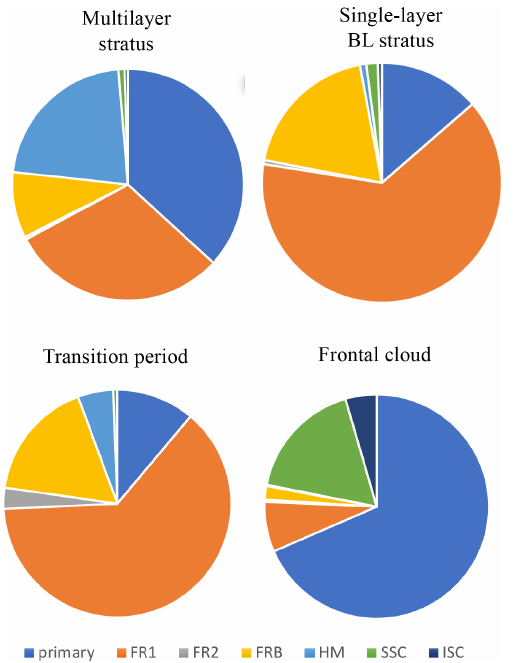
Figure 8. Pie charts showing the relative contributions to total ice production from primary production (i.e., ice nucleation), rime splintering (HM), fragmentation of frozen rain (including the small fragments in the first mode (FR1), big fragments in the first mode (FRB), and the second mode (FR2)), breakup from ice–ice colli- sions (including snow and cloud ice collision (ISC) and snow and snow collision (SSC)). During the four M-PACE periods, the verti- cally integrated process rates are used in the plot.